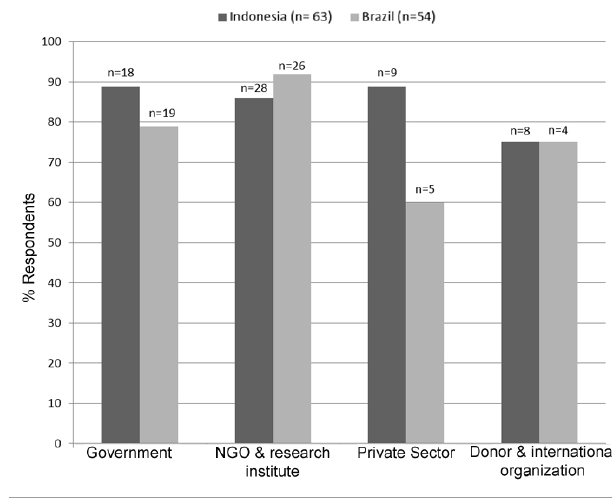
Fig. 3 . Percentage of respondents in the social organization survey in Brazil and Indonesia that agreed with the statement “Without involvement of local people in their implementation, REDD projects are unlikely to be effective.” Note: For the composition of the categories, see Fig.